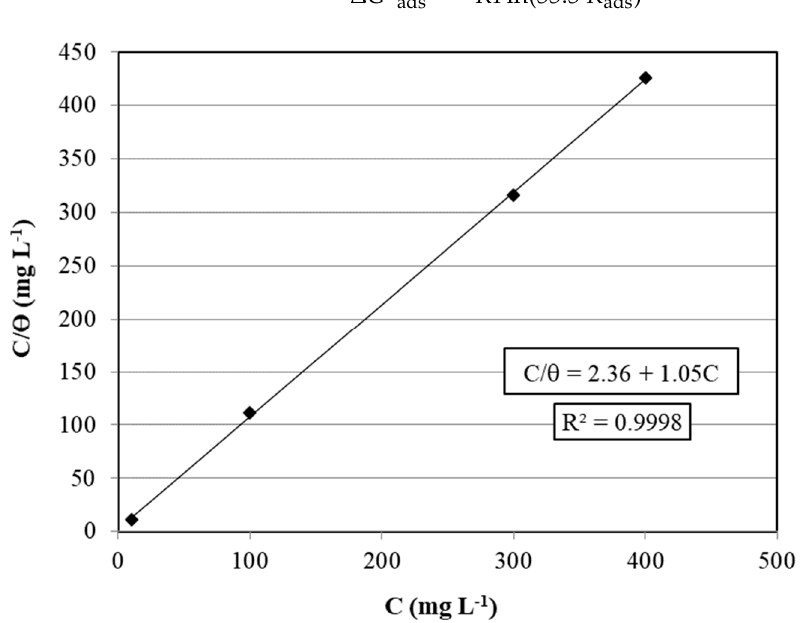
Figure 6. Plot of the Langmuir adsorption isotherm of Terminalia bellirica fruit extract on 304 stainless steel steel surface.